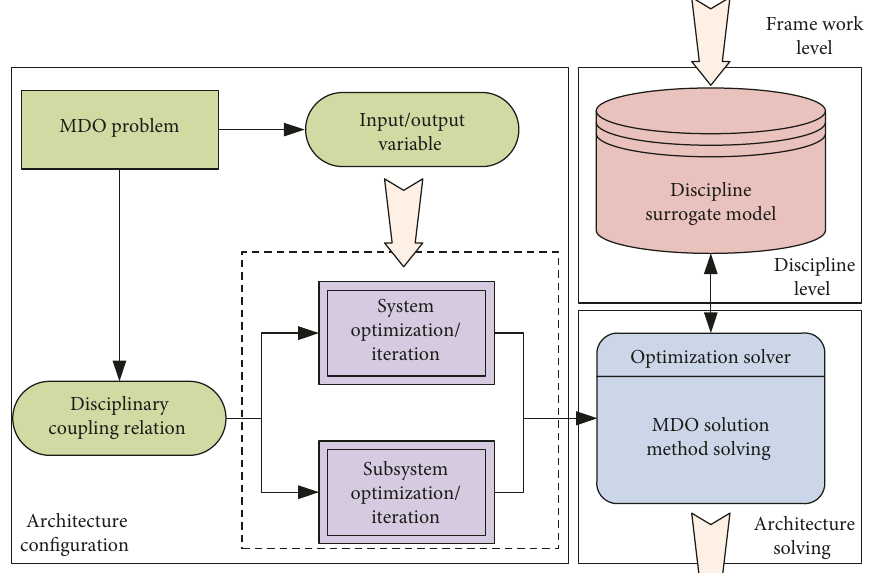
Figure 4: Flowchart of architecture